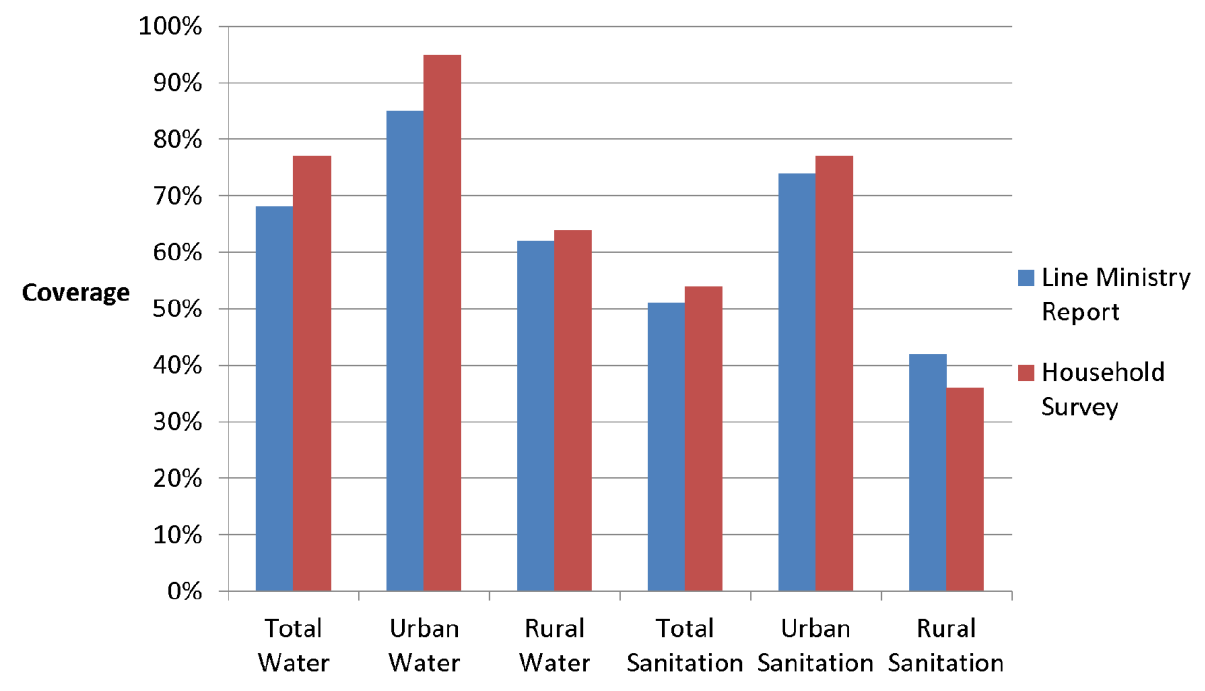
Figure 3. Comparison of 1990 global coverage estimates derived from provider-based line ministry data versus user-based (e.g., household survey and census) data